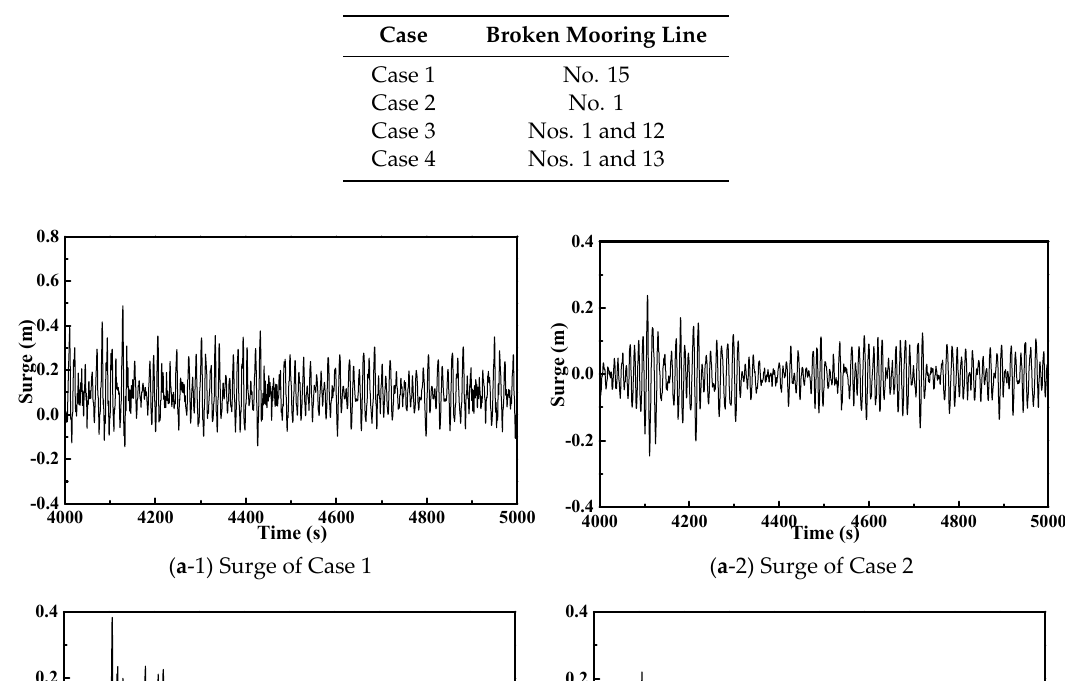
Table 8. Conditions of broken mooring lines.